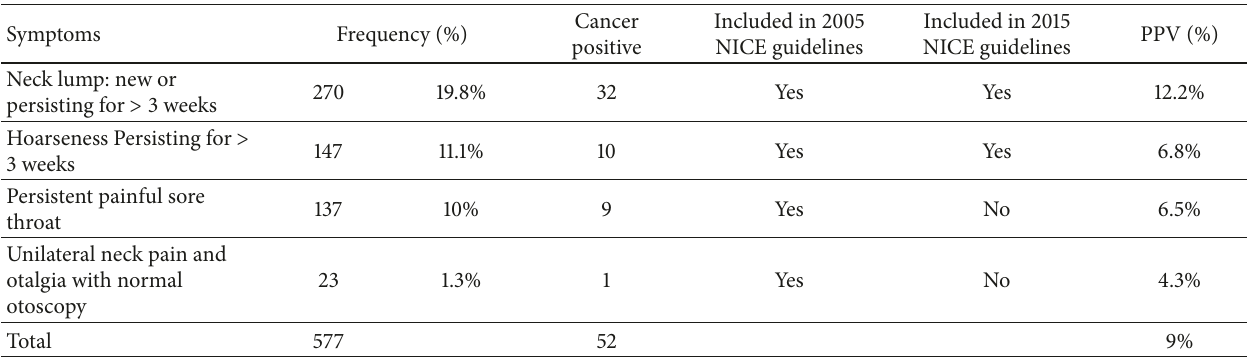
Table 2: Cancer detection rate in patients referred through 2 ww pathway and compliant with NICE